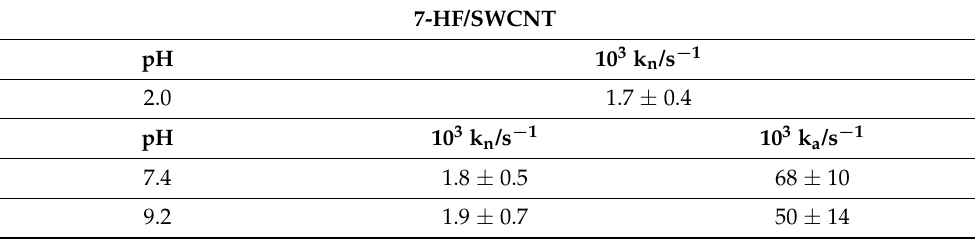
Table 3. First order rate constants obtained from the fittings of the dependence of %7-HF released on time, using Equation (9) for the data in acid medium, and Equation (10) for the data in neutral and basic media. The data correspond to the release of 7-HF from the SWCNT/7-HF complex. T = 310.0 ± 0.1